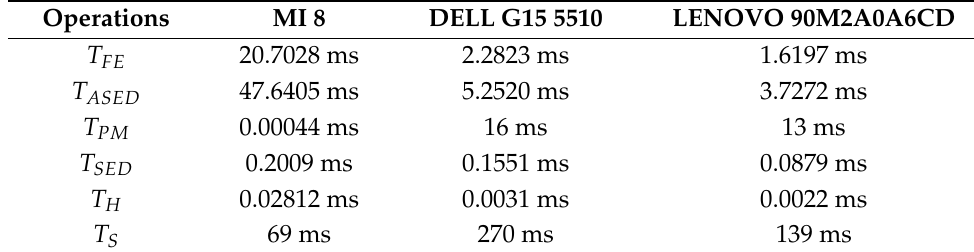
Table 5. Execution time of operations.